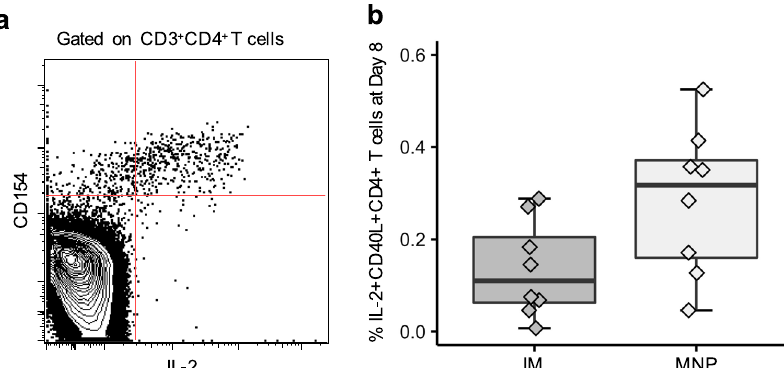
Fig. 6 IL-2 secreting CD4 + T cells after vaccination. a Representative FACS plot showing CD3 + CD4 + T cells expressing CD154 (CD40L) and IL-2 by ICS assay. b Percentage of vaccine-induced IL-2 + CD40L + CD4 + T cells at Day 8 by vaccine delivery group (MNP: n = 8; IM: n = 8). The box portion of the plot represents the interquartile range (IQR: 25th percentile, median, and 75th percentile) of the data. Error bars represent smallest and largest values within 1.5 times IQR. IM, IIV by intramuscular route; MNP, IIV by microneedle